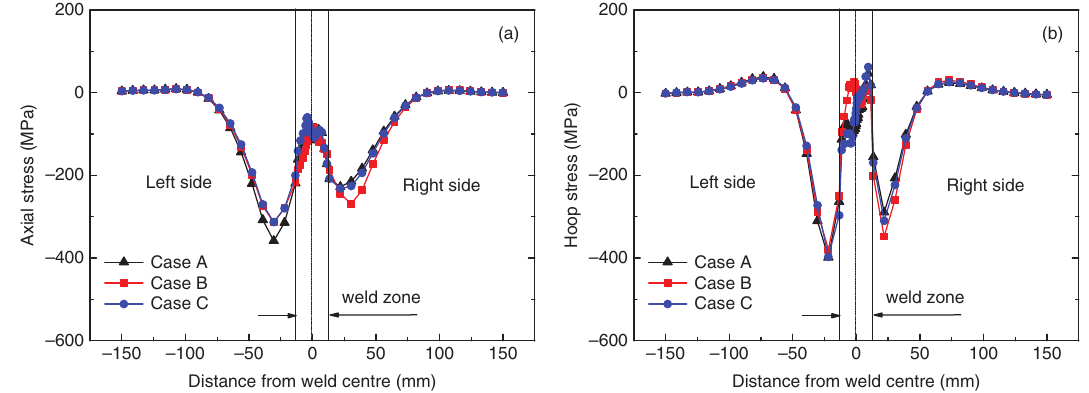
Figure 10: Residual stresses distributions at different welding sequences along path 1: axial stress (a), hoop stress (b).